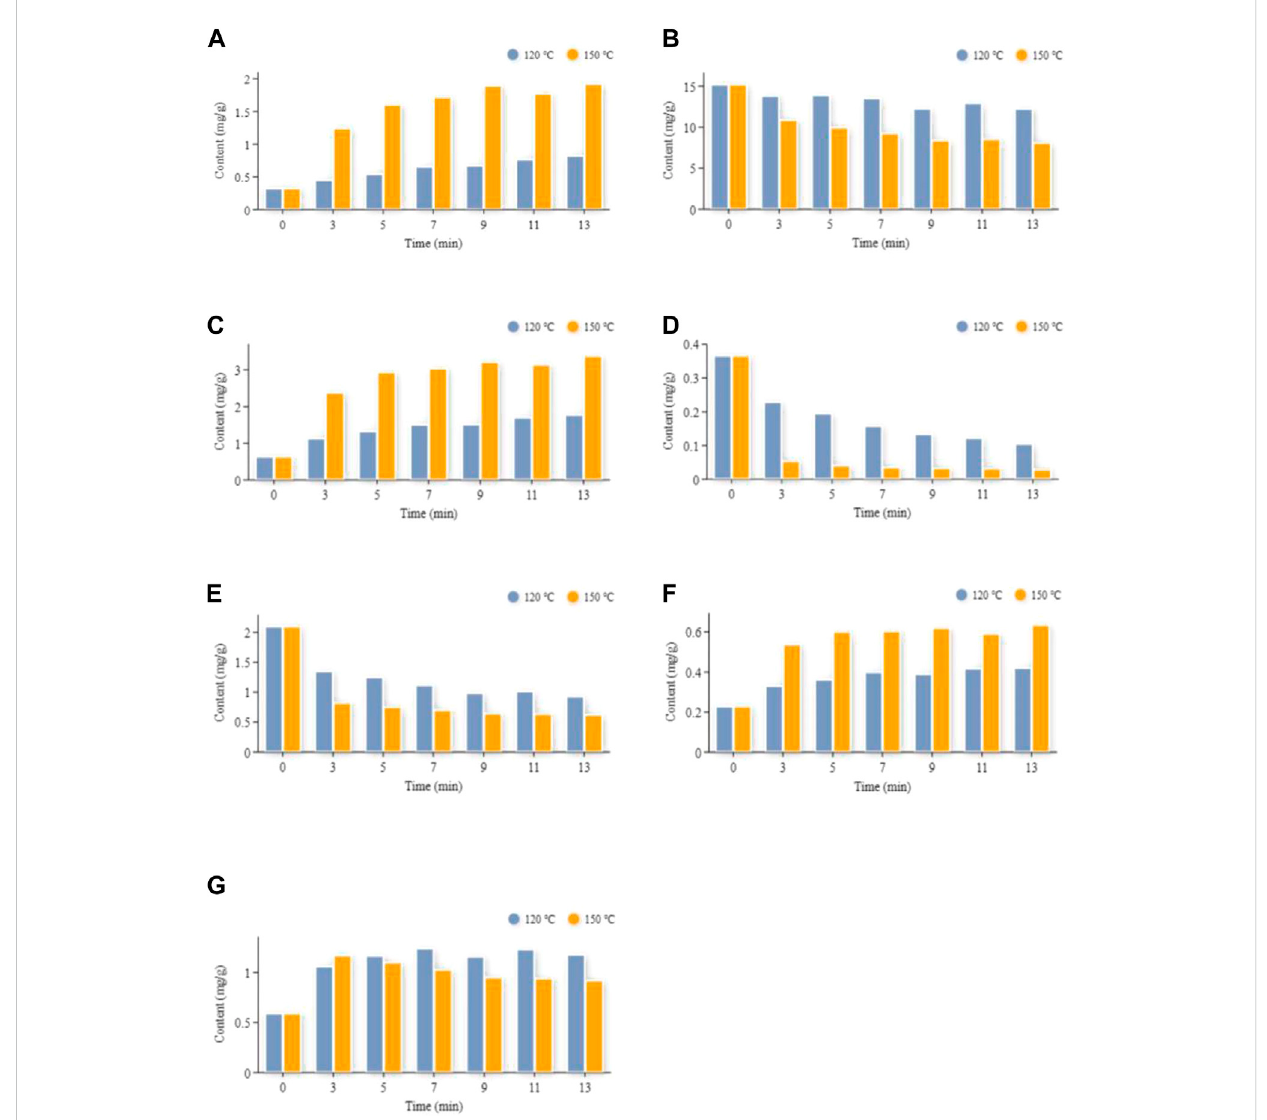
FIGURE 6 Change trend of the 7 phenolic acids in PS during the stir-frying process. (A) : 5-CQA; (B) : 3-CQA; (C) : 4-CQA; (D) : CA; (E) : 3,5-DiCQA; (F) : 3,4- DiCQA; (G) :